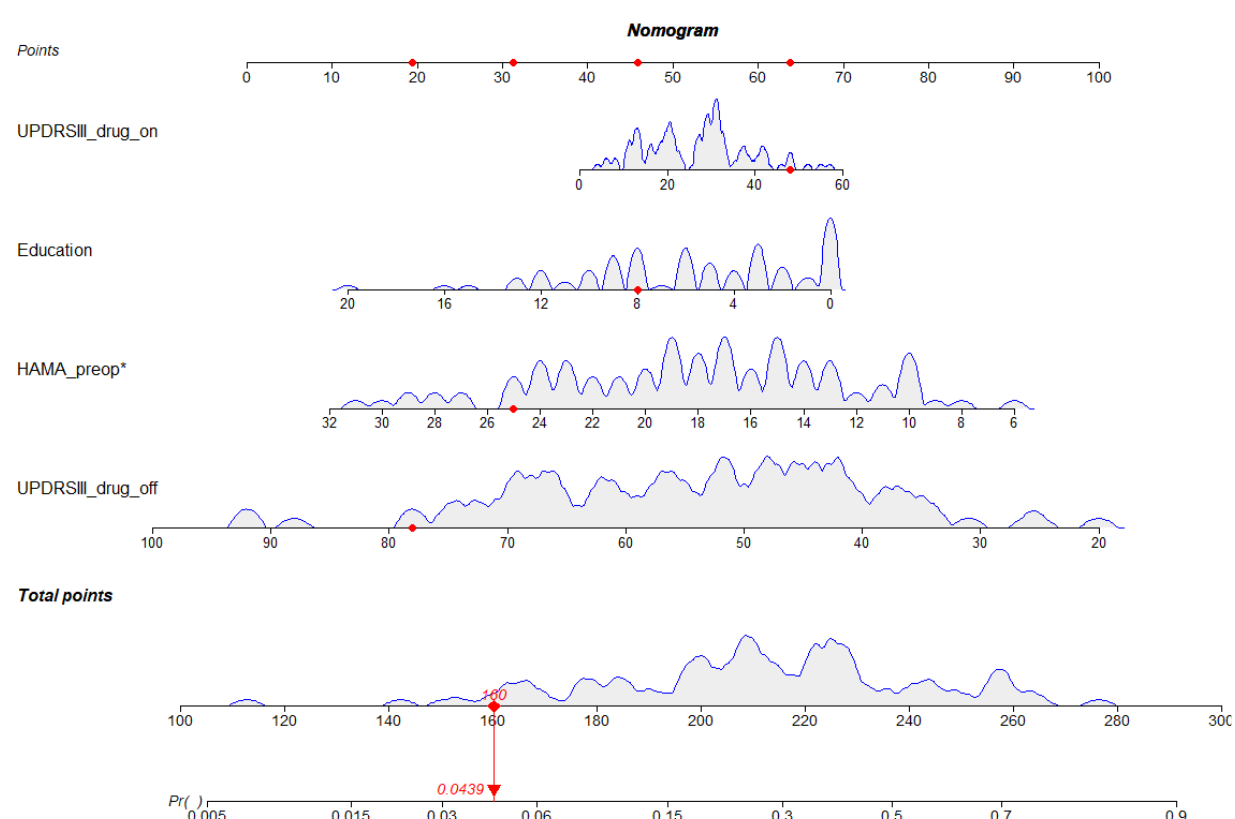
Figure 3. Nomogram to predict improvement of HAMA score after STN-DBS for PD. The clinical factor corresponds to a specific point by drawing a line straight upward to the point’s axis. After the sum of the points is located on the total points axis, the sum represents the probability of getting an HAMA score improvement. *, p < 0.001